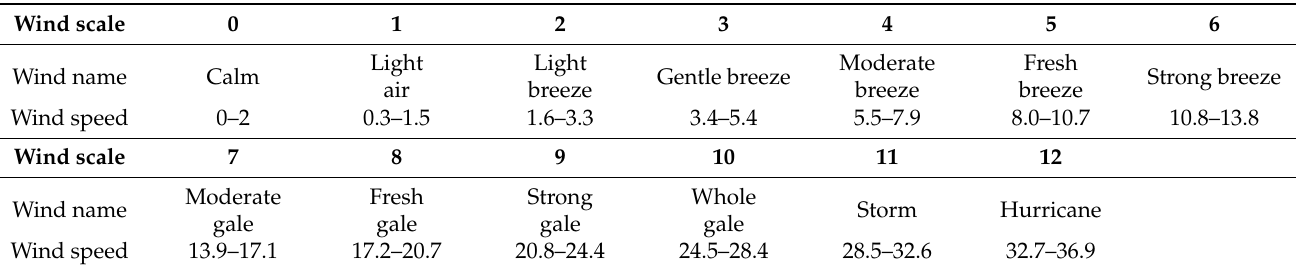
Table A1. The scale of wind force summary. (Unit: